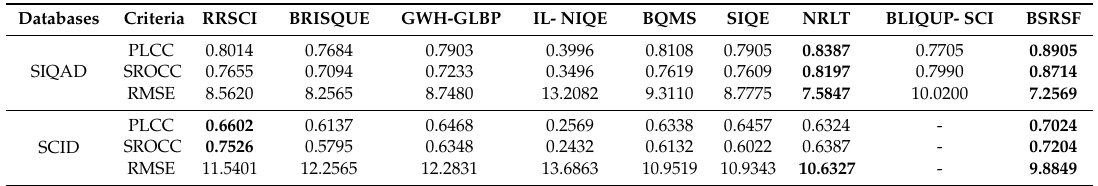
Table 2. Performance comparison of the proposed BSRSF model and reduced-reference (RR) and blind